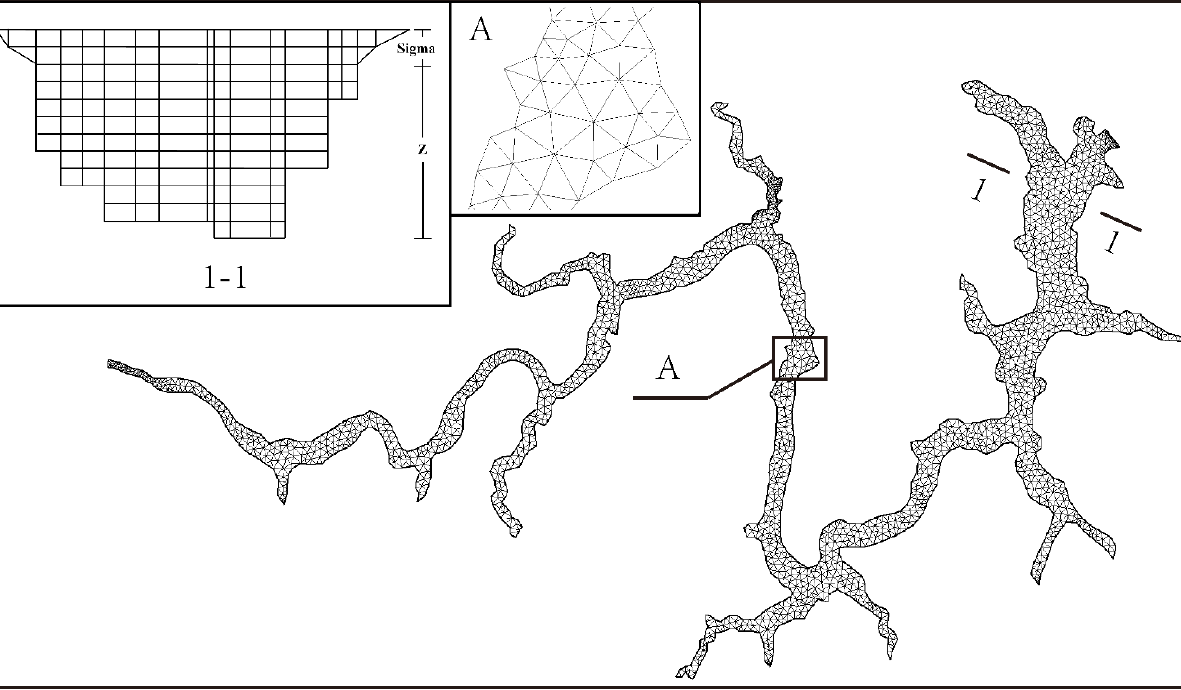
Figure 3. Discretization of 3DNM.